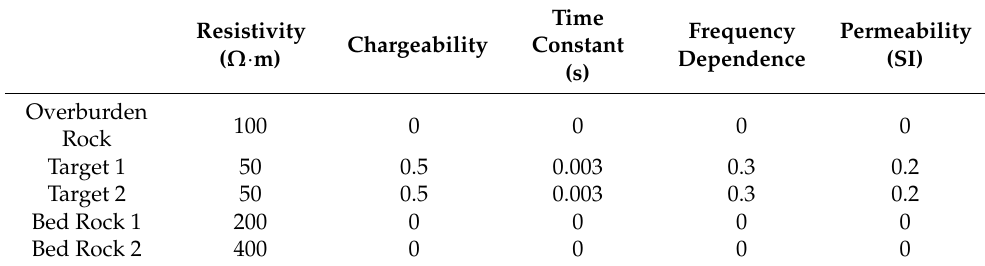
Table 2. Lithologic parameters of model 1.